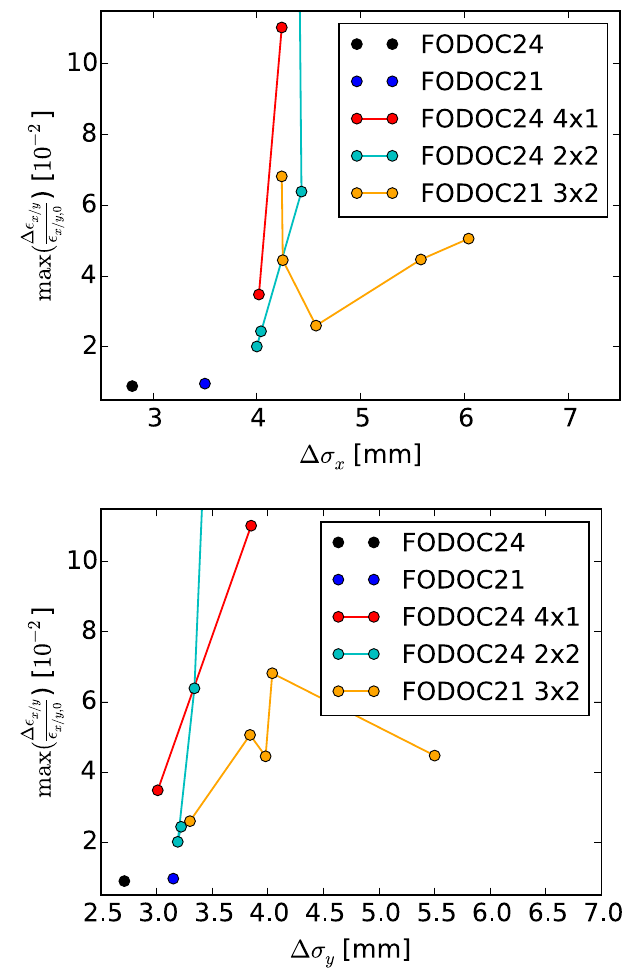
FIG. 24. Dependence of the maximum emittance growth on the variation of the beam size defined by Eq. (13) for the 24 and 21-cell FODO lattices with different dispersion suppressor schemes listed in Table